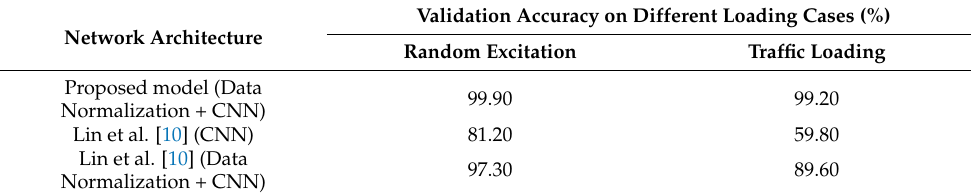
Table 6. Performance comparison of proposed